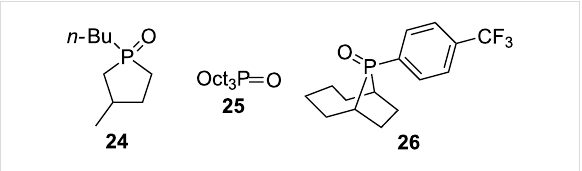
Figure 2: Various phosphine oxides used as